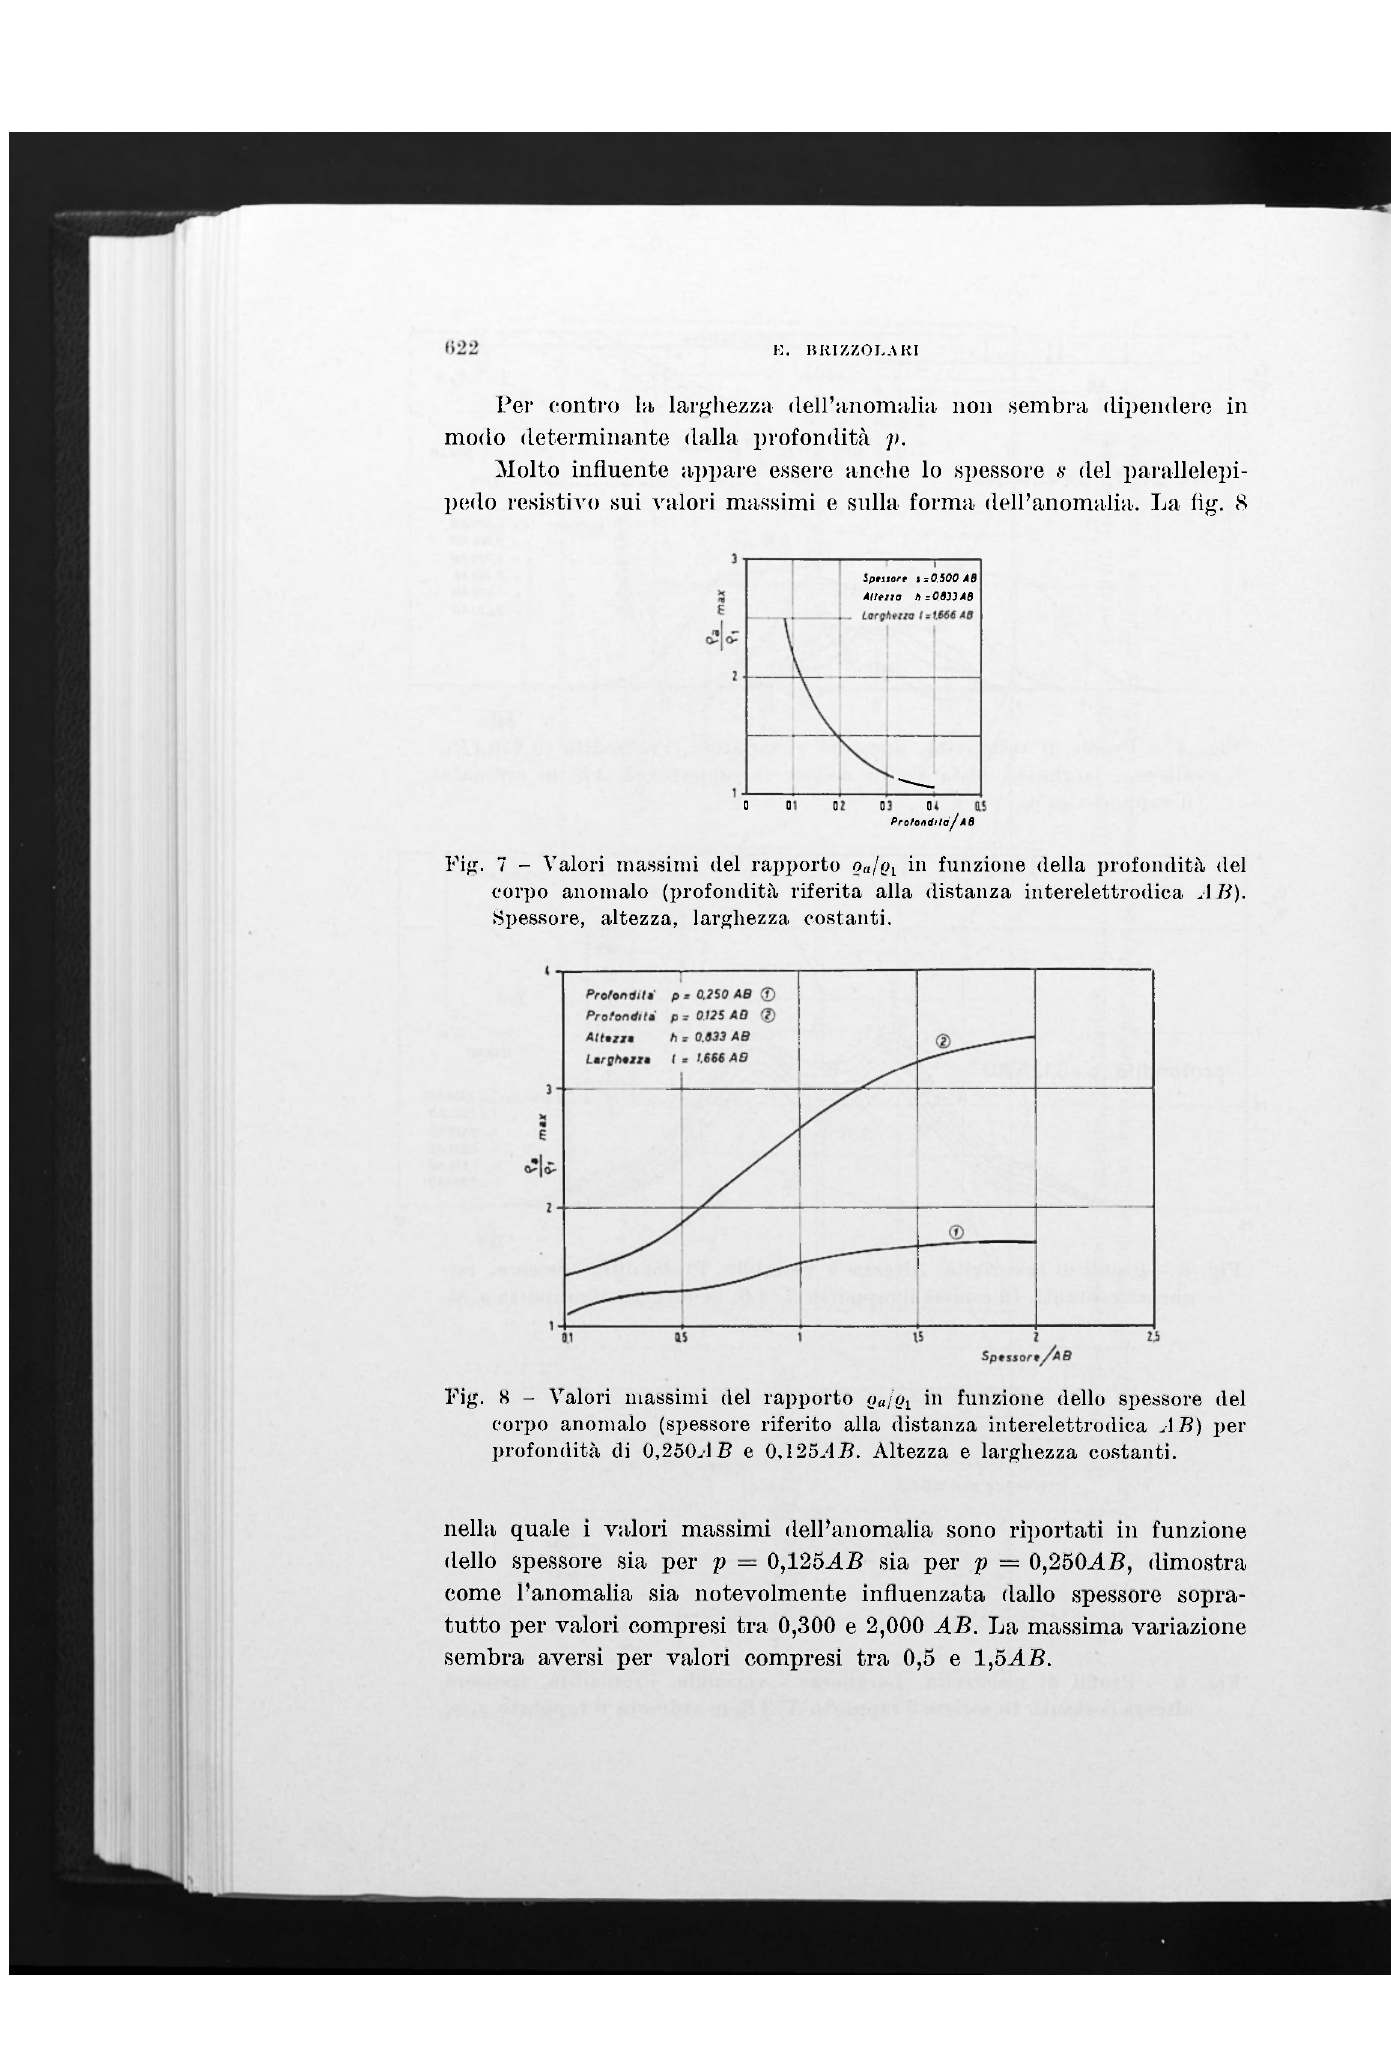
Fig. 7 - Valori massimi del rapporto o a /£>i in funzione della profondità del corpo anomalo (profondità riferita alla distanza interelettrodica AB).